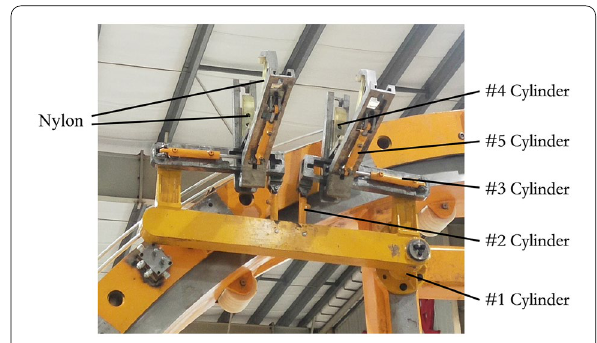
Figure 11 Steel arch splicing manipulator prototype